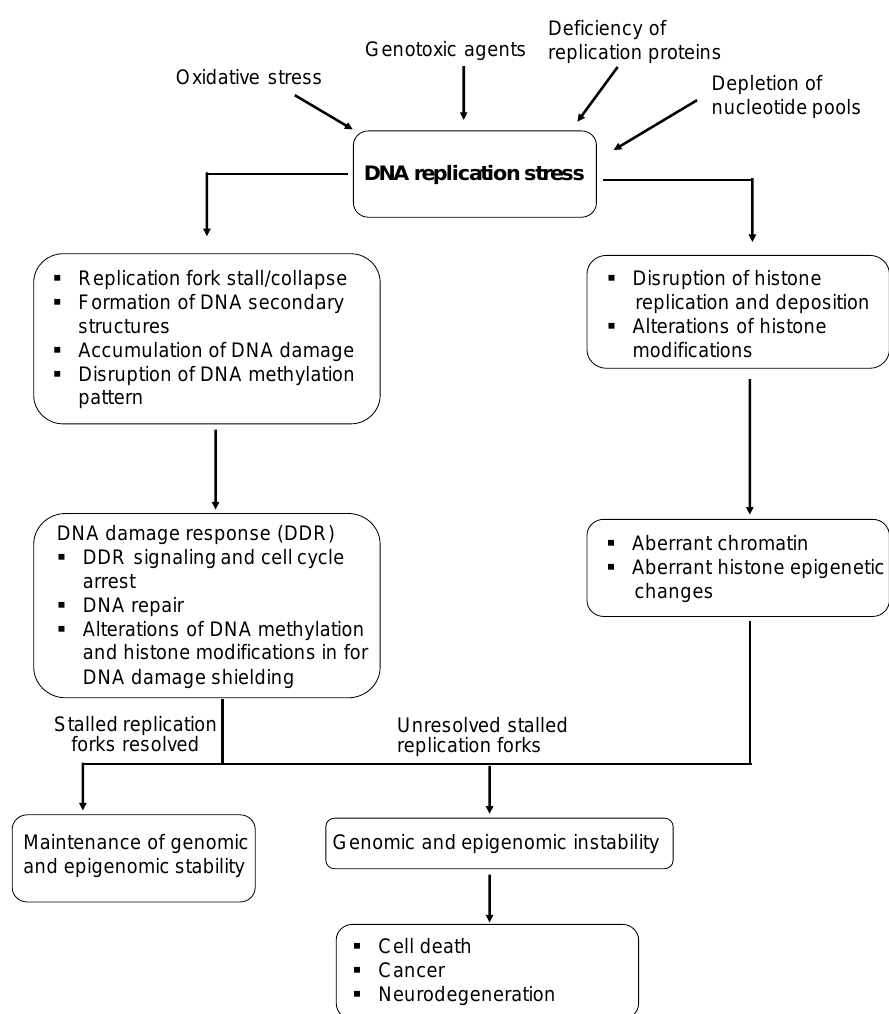
Figure 1. DNA replication stress leads to genomic and epigenomic instability associated with diseases.